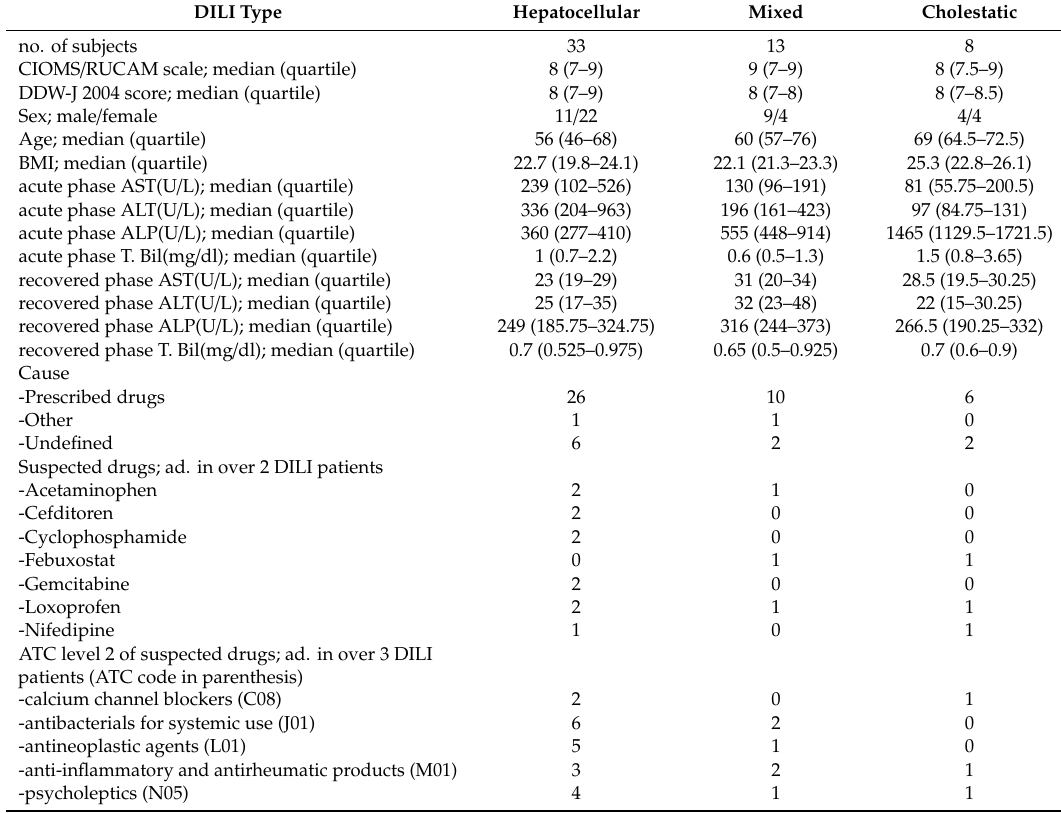
Table 1. Clinical information of patients in this